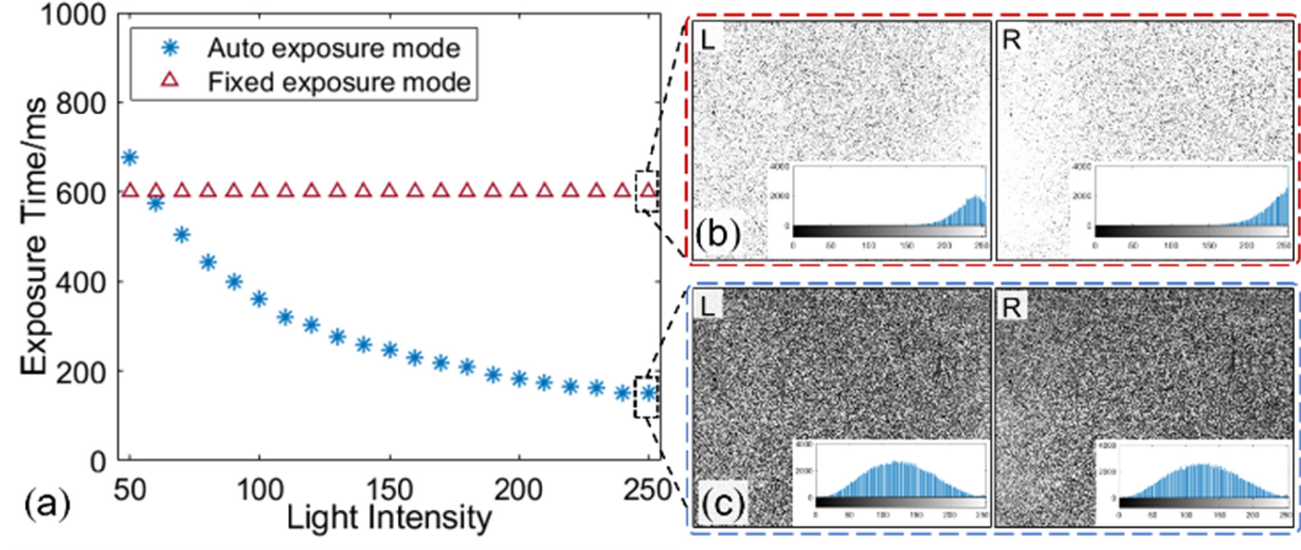
Figure 5. ( a )The exposure time varies with the ambient light under two modes, image pair captured by the ( b ) fixed exposure mode and ( c ) auto exposure mode at light intensity of 250